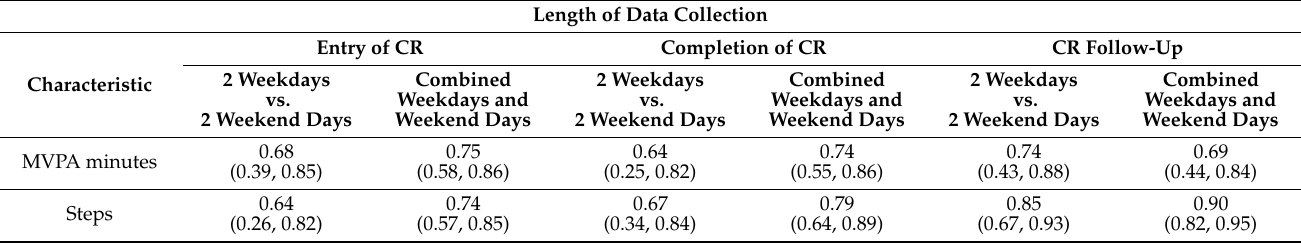
Table 2. Estimated ICCs for Fitbit-Flex for measuring step counts and minutes of MVPA.